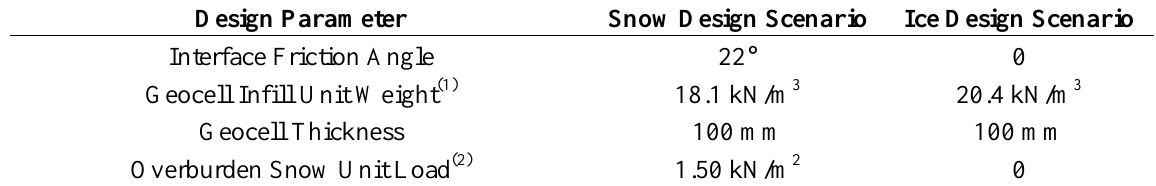
Table 2. Cover system design